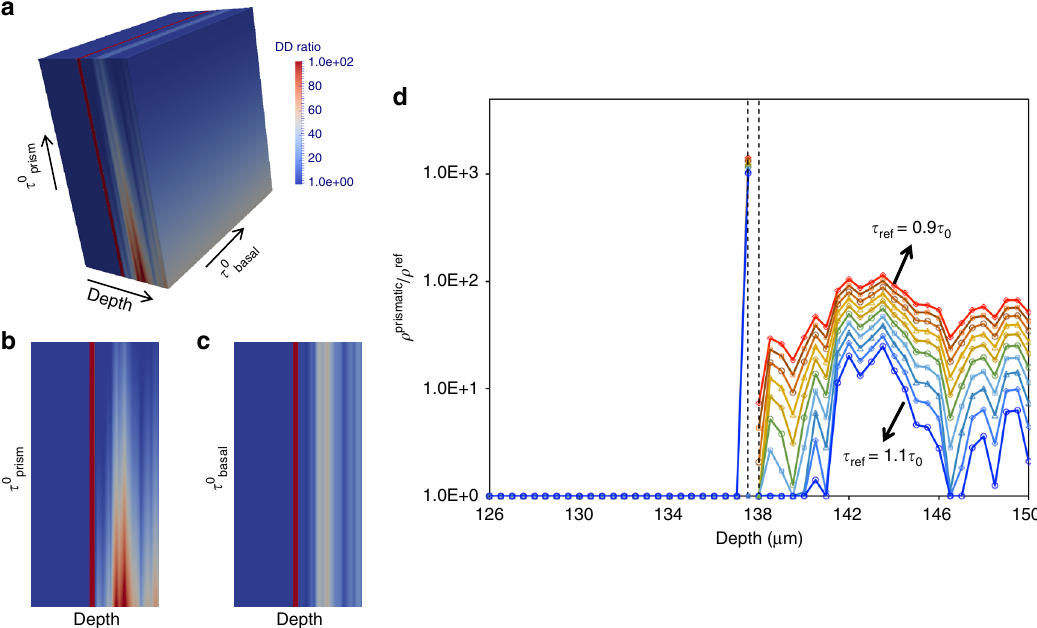
Fig 5 Asymmetric distribution of prismatic dislocation density ratio. a Calculated prismatic slip-1 dislocation density ratio ( = ρ Prismatic / ρ ref ) pro fi le for different basal and prismatic modes threshold shear stress values. The range for threshold stress values of basal and prismatic modes is ±10% of its CRSS. b , c DD ratio pro fi le for fi xed basal and prismatic modes threshold shear stress values ( = actual CRSS), respectively. d The distribution of DD ratio for different prismatic threshold shear stress values while fi xing basal threshold shear stress value. The reference dislocation density is 1 × 10 12 m − show the distribution of dislocation density ratio along line A-B for a set of selected threshold stress values of prismatic slip in Fig. 5d. The dislocation density ratio is high for low reference value and vice versa.